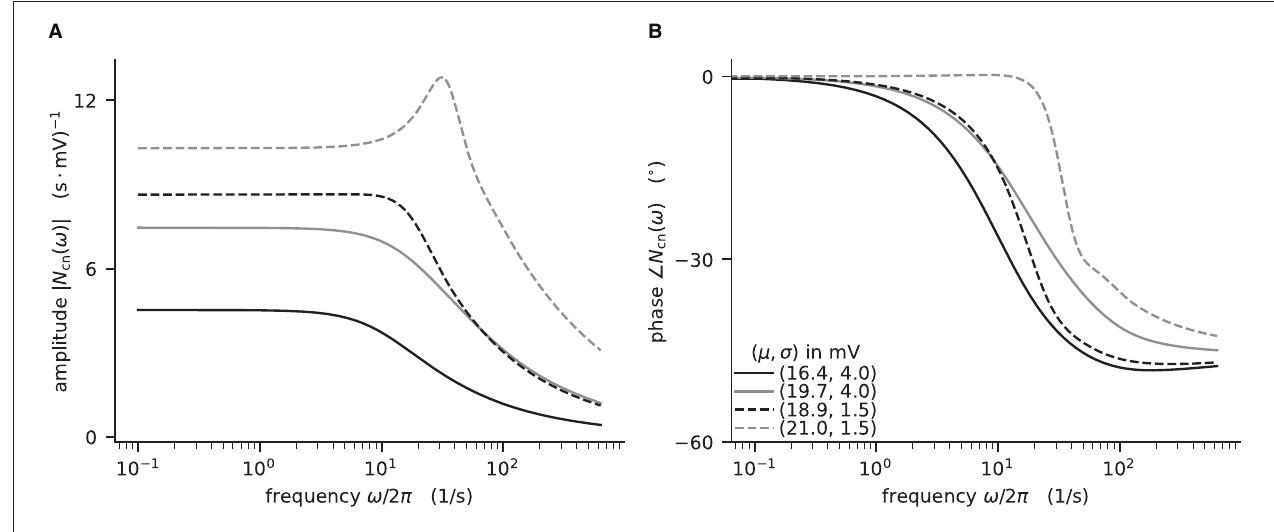
FIGURE 4 | Colored-noise transfer function N cn of LIF model in different regimes. (A) Absolute value and (B) phase of the “shift” version of the transfer function as a function of the log-scaled frequency. Neuron parameters are set to V th current, σ 4mV (solid line) and σ 1.5mV (dashed line), the mean input µ is chosen such that firing rates ν = = nnmt.lif.exp._transfer_function